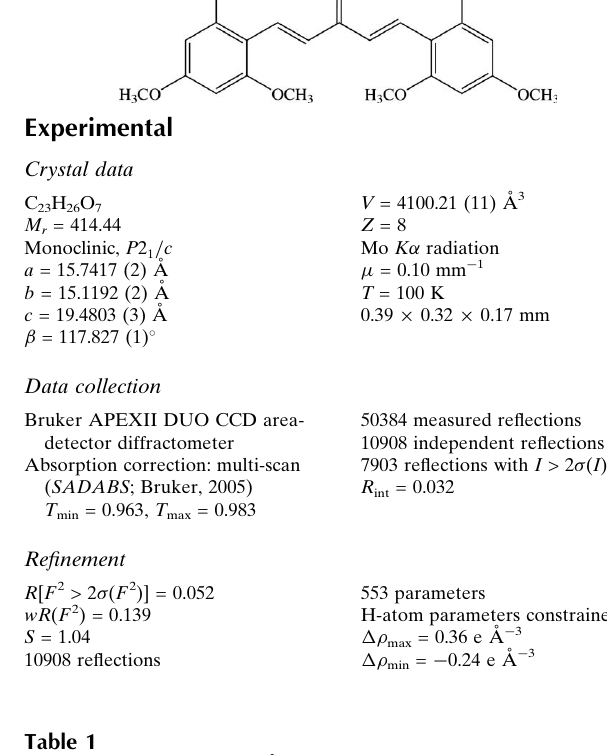
Hydrogen-bond geometry (A˚ , (cid:2)